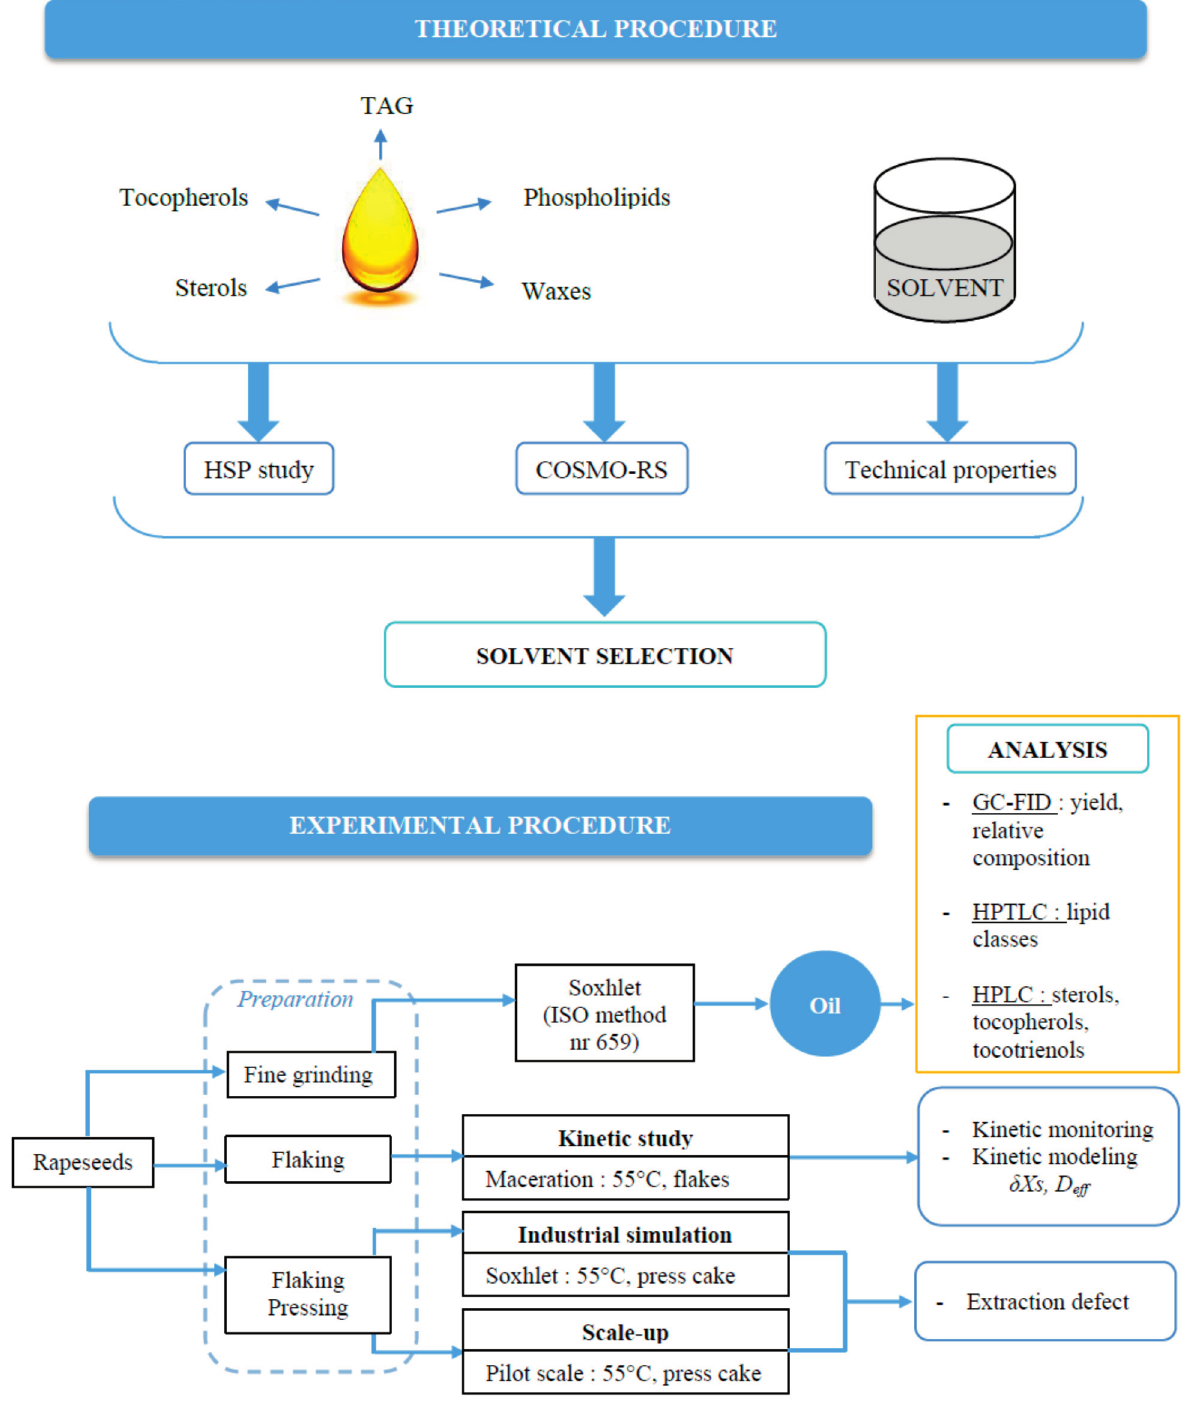
Figure 1. Scientific approach (TAG: triglycerides; COSMO-RS: COnductor-like Screening MOdel for Realistic